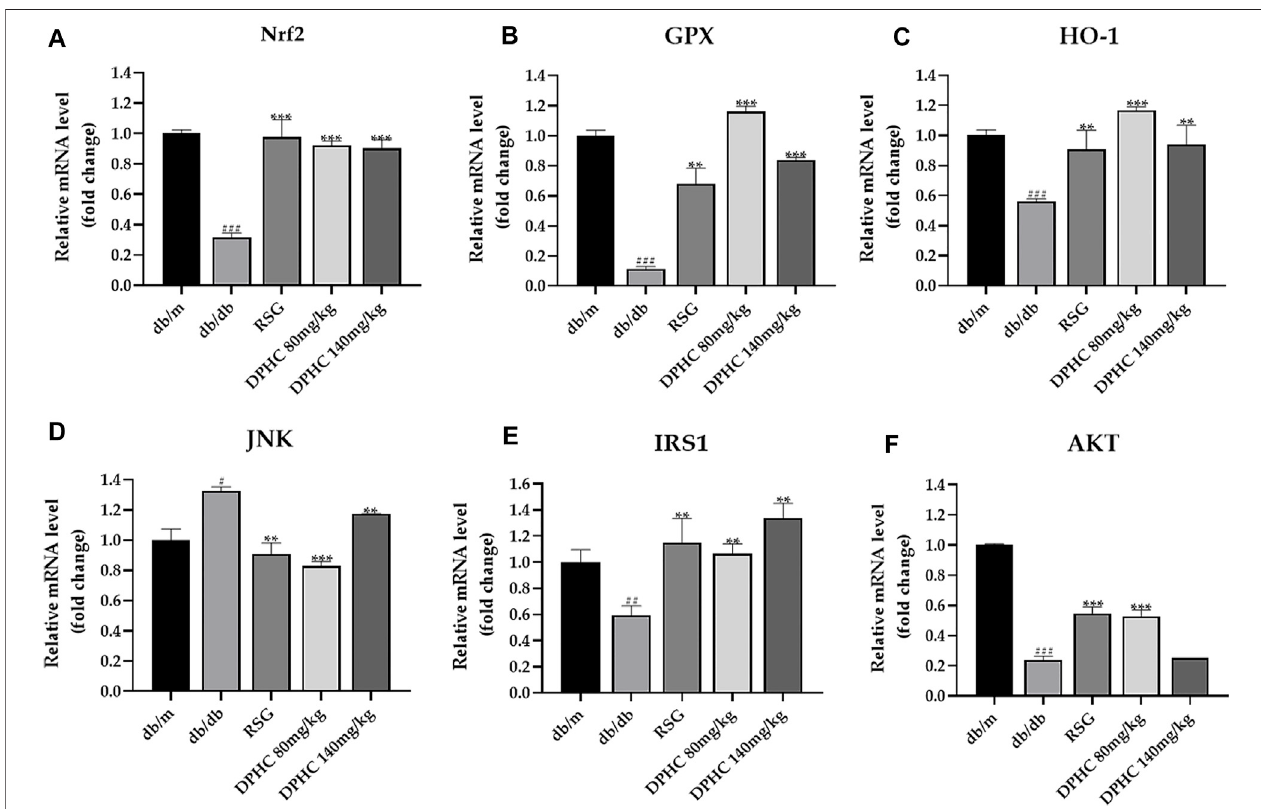
FIGURE 7 | Effects of DPHC on improving oxidative stress and IR via Nrf2/ARE signal pathway-related mRNA in liver tissues of db/db mice. (A) Nrf2 . (B) GPX . (C) HO-1 . (D) JNK . (E) IRS1 . (F) AKT .Theresultsofdifferentgroupswerenormalizedaccordingtotheresultsofdb/mgroup.Allvaluesareexpressedasmeans ± SD,n (cid:1) 3. * p < 0.05, ** p < 0.01, *** p < 0.001 compared with the db/db group, and ## p < 0.01, ### p < 0.001 compared with the db/m